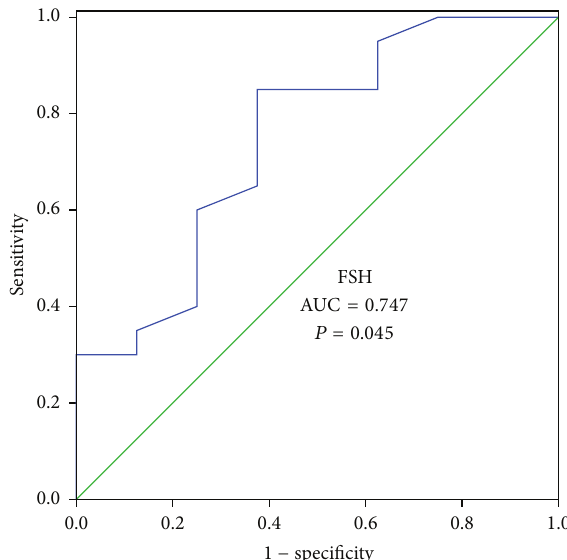
Figure 3: FSH diagnostic utility for natural pregnancy occurrence (ROC